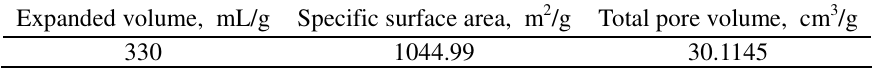
Table 1. Structural parameter of EG a